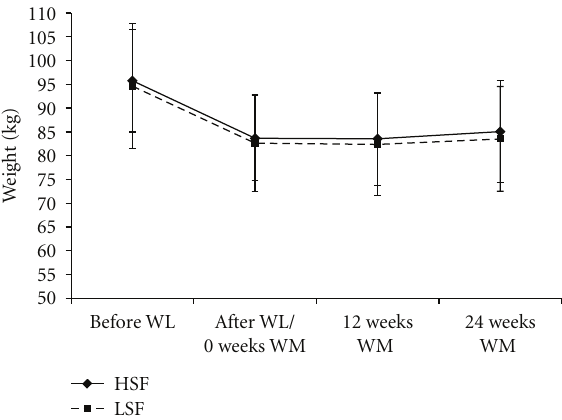
Figure 1: Changes in the body weight during the study. No significant di ff erences between the groups. HSF: higher-satiety food group ( n = 42); LSF: lower-satiety food group ( n = 40); WL: weight loss; WM: weight